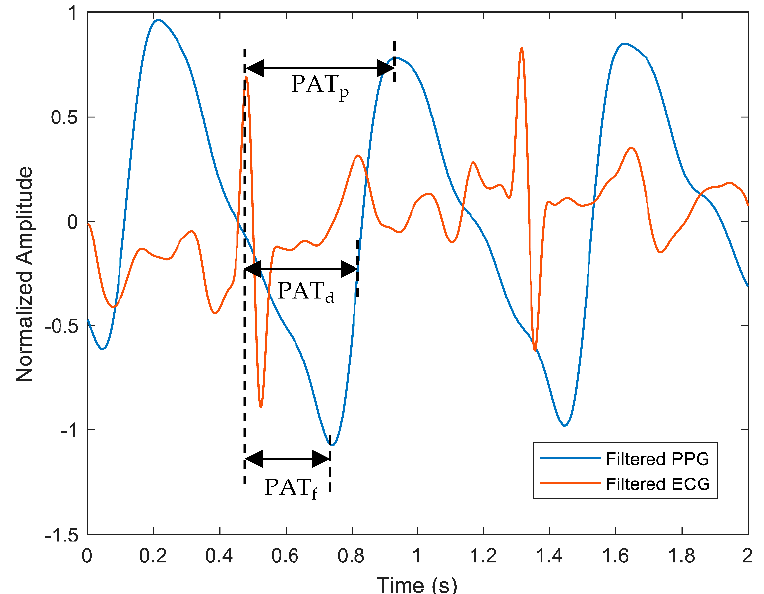
Figure 7. A representation of PAT calculation measured from the R-peak of the ECG signal to specific points of the PPG signal, such as peak of the PPG (PAT p ), midpoint of the PPG (PAT d ), and foot of the PPG (PAT f ). Red and blue waveforms represent filtered ECG and PPG, respectively.